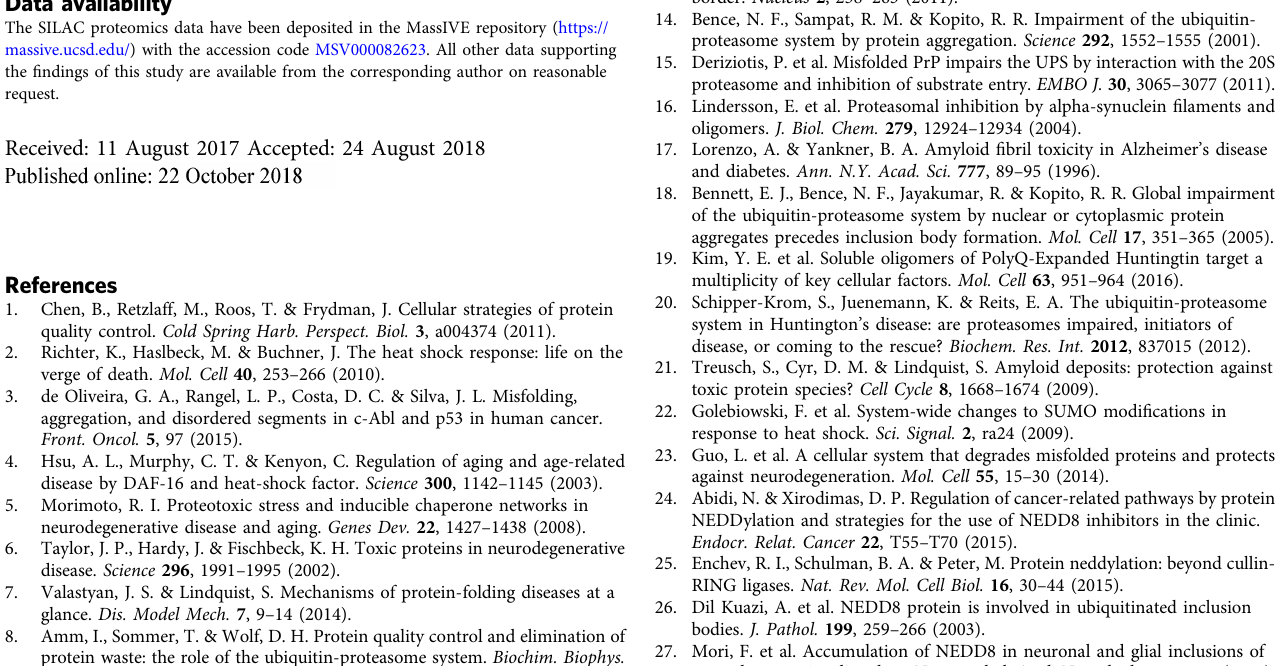
Data availability The SILAC proteomics data have been deposited in the MassIVE repository (https:// massive.ucsd.edu/) with the accession code MSV000082623. All other data supporting the fi ndings of this study are available from the corresponding author on reasonable request.